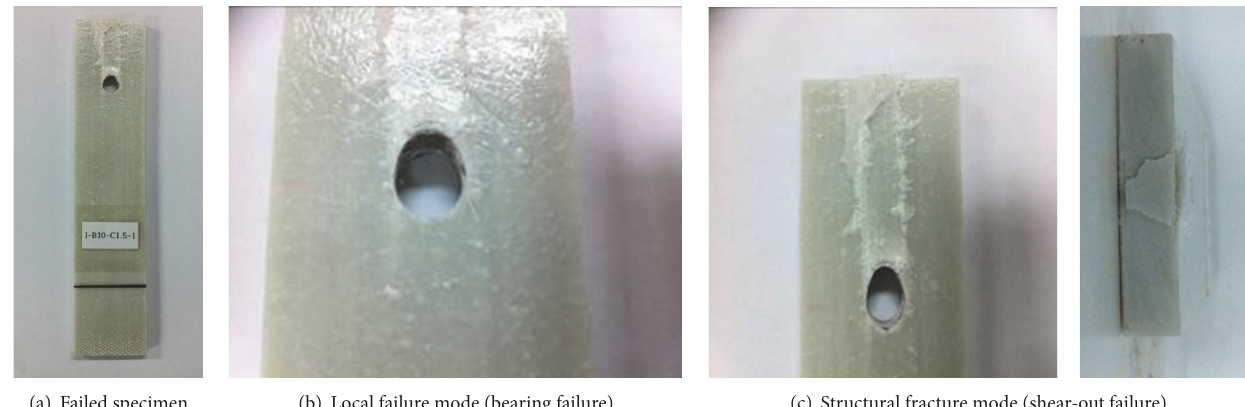
Figure 10: Examples of local failure and structural fracture modes (I-B10-C1.5